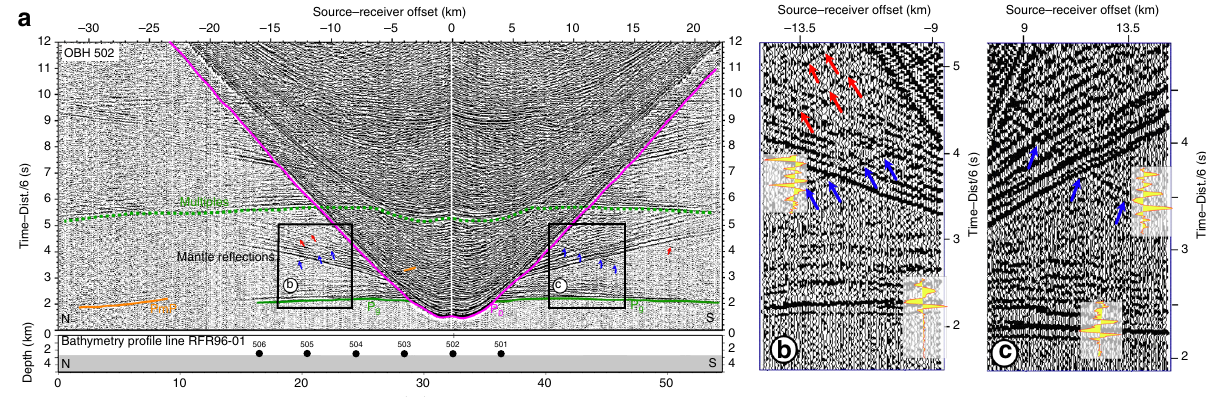
Fig. 2 Wide-angle seismic data recorded on OBH 502 along pro fi le RFR96-01. a The primary seismic phases are direct water wave (P 0 , magenta), crustal P-wave refractions (Pg, green) and crust-mantle boundary (Moho) P-wave re fl ections (PmP, orange). The presence of multiples is shown in a dashed green line. The mantle re fl ection events, the focus of this study, are marked in blue and red arrows. In green arrows, we mark P-to-S converted energy. The black boxes ( b ) and ( c ) show the close-up regions on the right focusing on the mantle re fl ection events (blue and red arrows). Yellow fi lled red curves indicate seismic waveforms for Pg and mantle re fl ected waves demonstrating the polarities of the mantle re fl ections. The bottom panel shows sea fl oor bathymetry along the line with the location of OBH